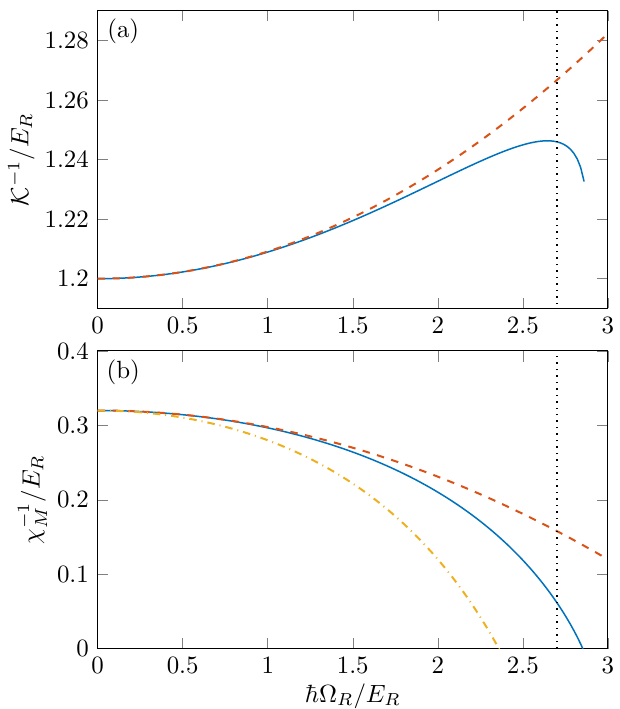
Figure 3: (a) inverse compressibility and (b) inverse magnetic susceptibility as func- tions of the Raman coupling Ω . The meaning of the lines is the same as in Fig. 1: the R blue solid ones show the exact values determined numerically, while the red dashed ones correspond to the perturbation results up to second order in ħ h Ω yellow dash-dot line in (b) corresponds to the low-density prediction (56) and van- = 2.35 E ishes at ħ h Ω . The vertical black dotted lines at ħ h Ω R R the transition to the plane-wave phase. The interaction parameters are the same as Fig.